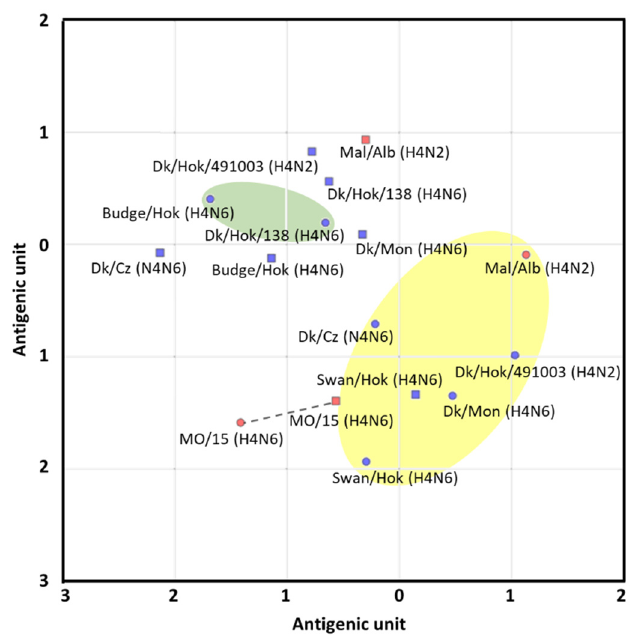
two dots on the map represents the antigenic distance. Blue and red dots indicate the isolates belonging to the Eurasian and North American lineages, respectively. The antigenic group is shown in yellow or green. The dotted line represents homologous combination. The spacing between grid lines is equivalent to an antigenic unit distance corresponding to a two-fold HI difference.